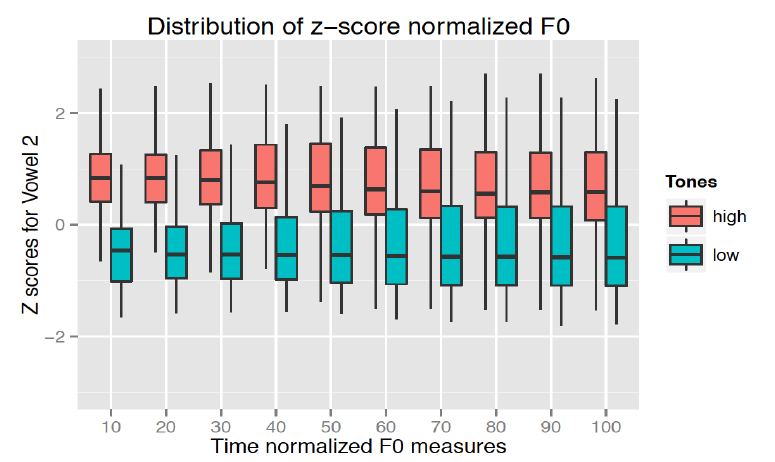
Figure 22: Box plots showing well-differentiated f0 of the second vowel 10 – 100% of the